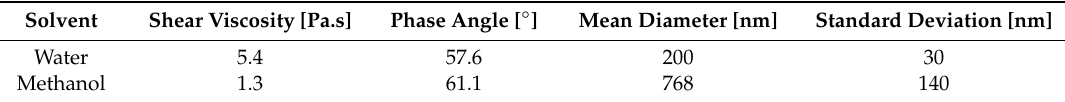
Table 2. Rheological properties of PEO solutions (9 wt.%) measured at 20 ◦ C and the mean diameter of